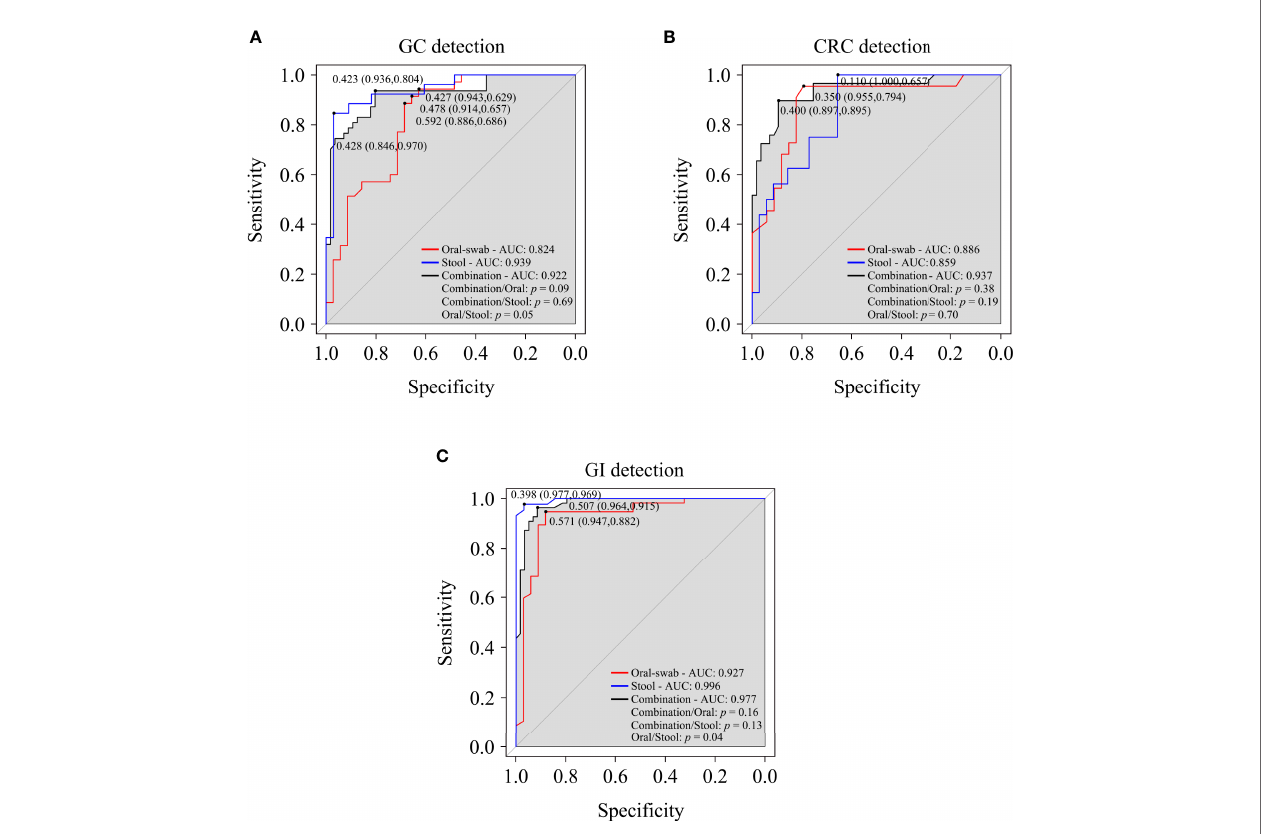
FIGURE 9 | Oral and fecal microbiota spectrum may be a new non-invasive detection for GC, CRC, and gastrointestinal (GI) cancers. Through the analysis the AUC of POD index, and using microbiota pro fi les from oral swabs, stool, or a combination of both to predict GC (A) , CRC (B) , and GI cancers (C) . ROC, receiver operating characteristic curves; AUC, area under the